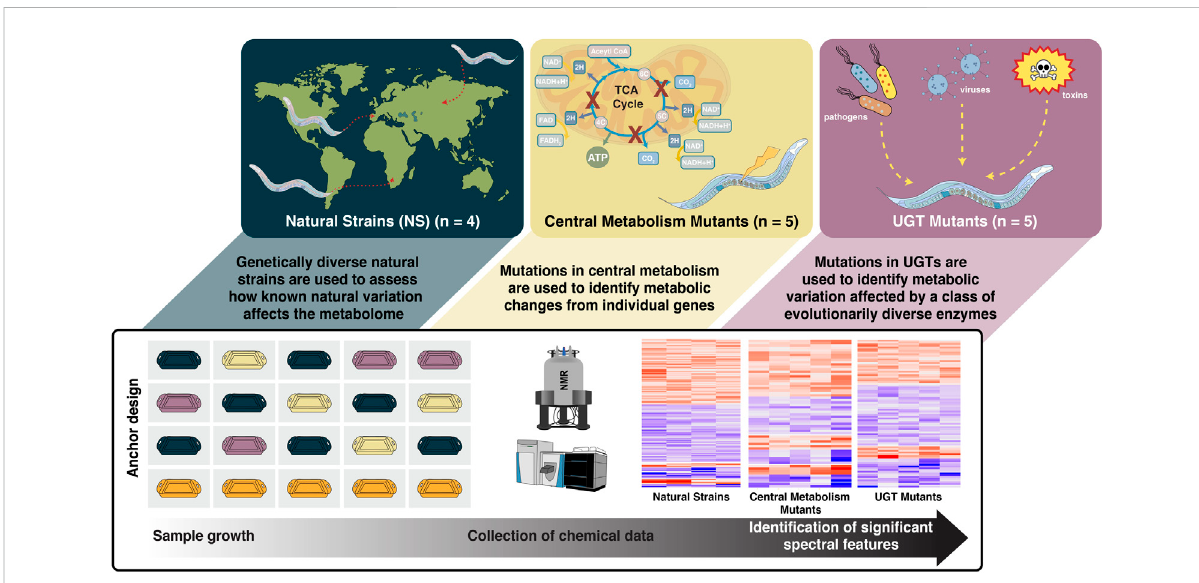
FIGURE 1 Fourteen C. elegans strains are evaluated in three genetic studies (natural strains, central metabolism mutants, and UDP- glucuronosyltransferase mutants). PD1074, the anchor control strain (orange), is grown alongside test strains (green, yellow, purple). Multiple biologicalreplicatesofPD1074captureenvironmentalvariationingrowthconditions.Non-polarandpolarmetabolicdatawerecollectedbynuclear magnetic resonance (NMR) spectroscopy and liquid chromatography-mass spectrometry (LC-MS). Data acquisition controls included biologicalreferencematerial,pooledPD1074,pooledteststrains,andextractionblanks.BiologicalreplicatesofPD1074(n=42forLC-MS,n=52for NMR) were assayed individually and allocated across all data acquisition batches. Meta-analysis between PD1074 and individual test strains provided comparable inferences to mixed effects models, and the resulting estimated relative effects of each test strain to PD1074 provide straightforward comparisons of test strains between